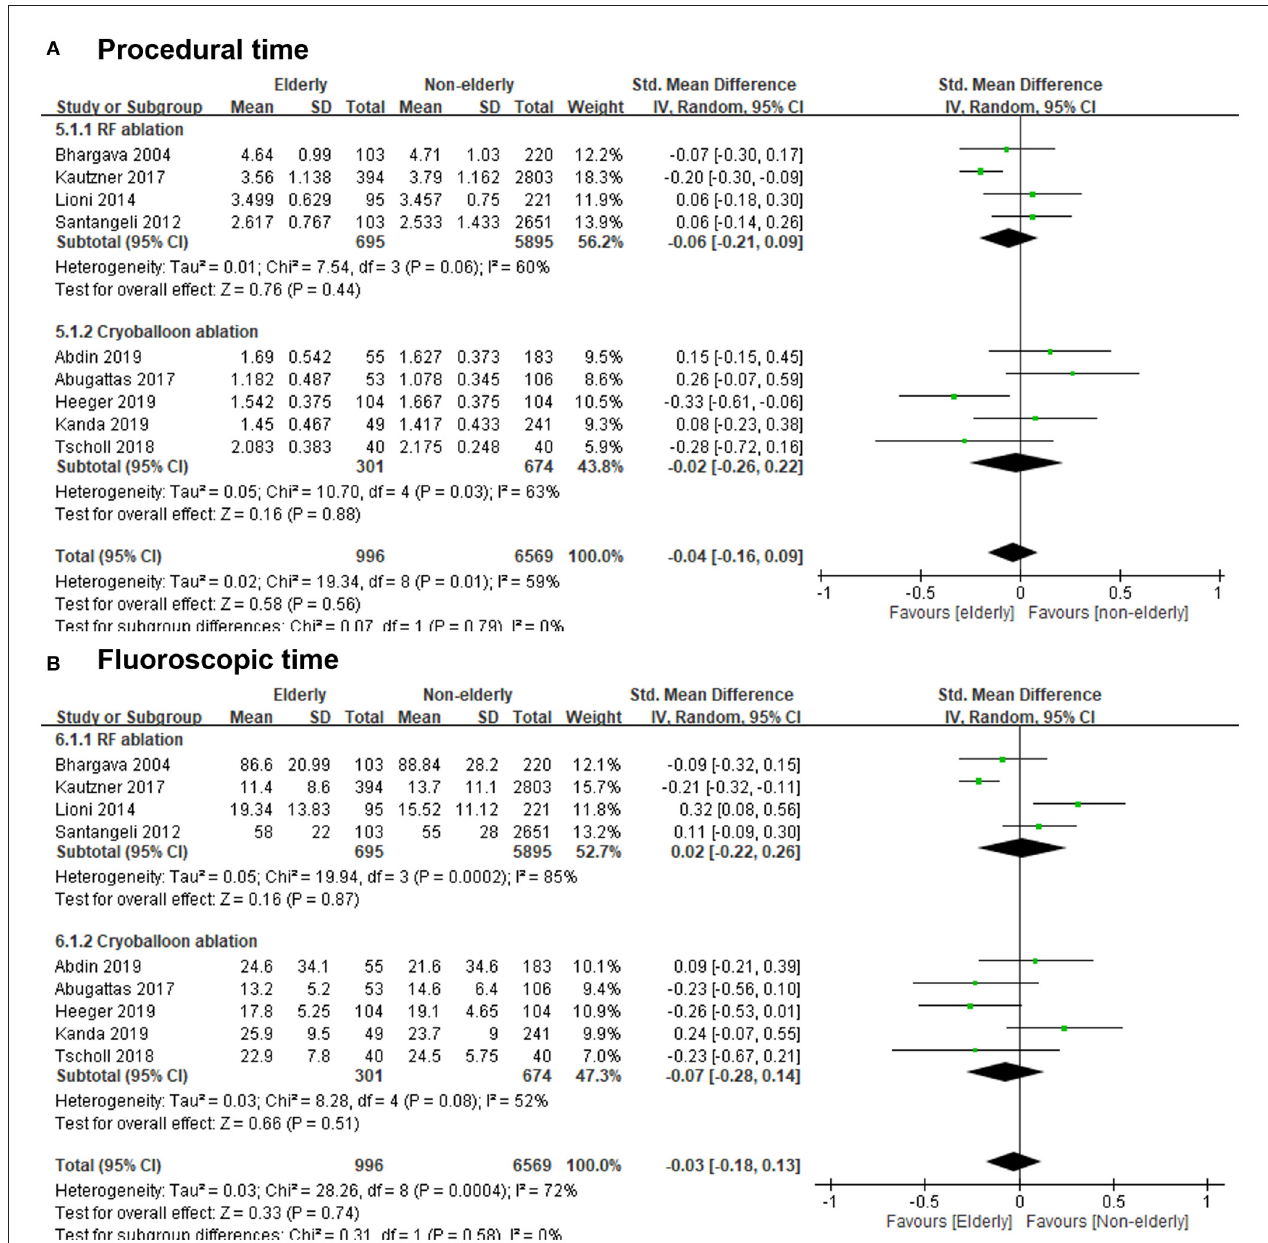
FIGURE 7 | (A) Forest plots of the standardized mean differences (SMDs) of procedural time of RF ablation or cryoballoon ablation in the elderly vs. non-elderly group from nine studies. (B) Forest plots of the SMDs of fluoroscopic time of RF ablation or cryoballoon ablation in the elderly vs. non-elderly group from nine studies.